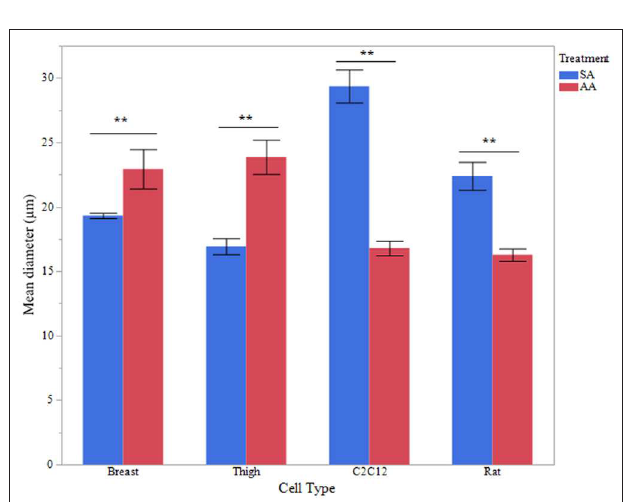
FIGURE 4 | Myotube diameter. Myotube Diameter of primary breast, primary thigh, C2C12, and primary rat myotubes ( n = 100 myotubes from 10 independent wells) treated with sodium acetate (10mM) or ammonium acetate (10mM) for 24h. Asterisks represent significant differences between treatments for each cell type (** P < 0.01).